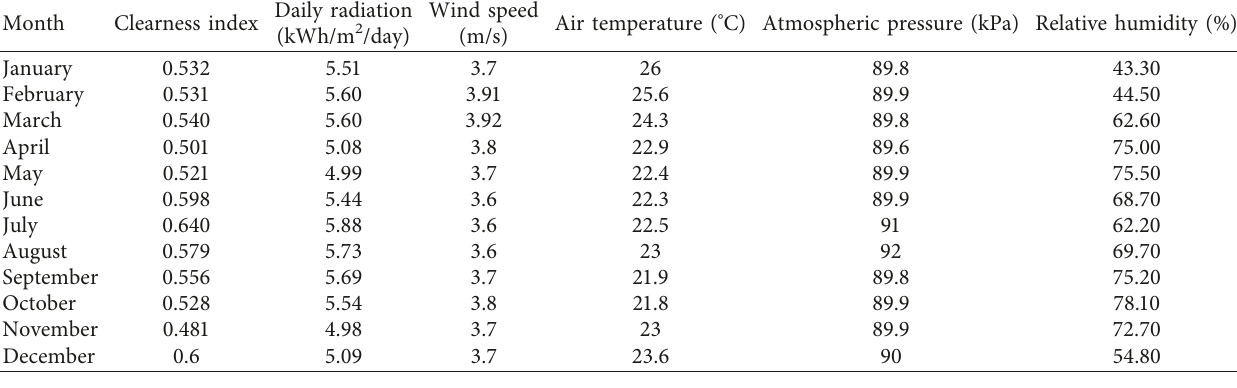
Table 2: Monthly meteorological data observatory for the selected village Mutobo [17].